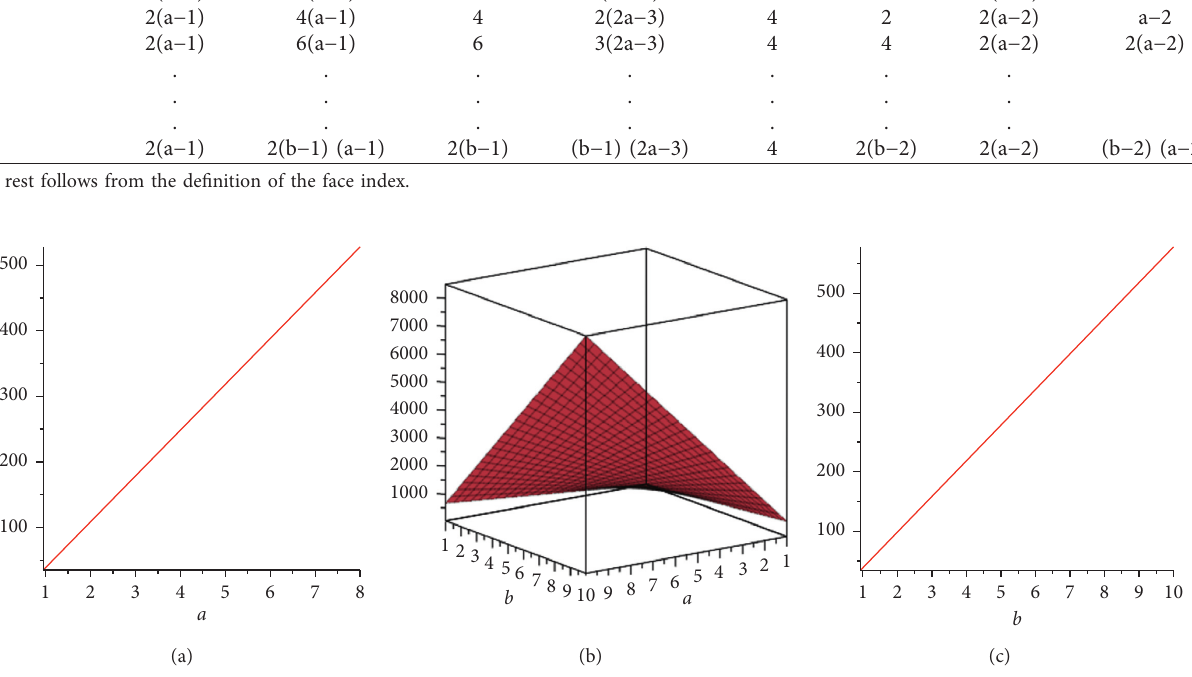
C − III [ a, 1 ]) , FI ( Si 2 3